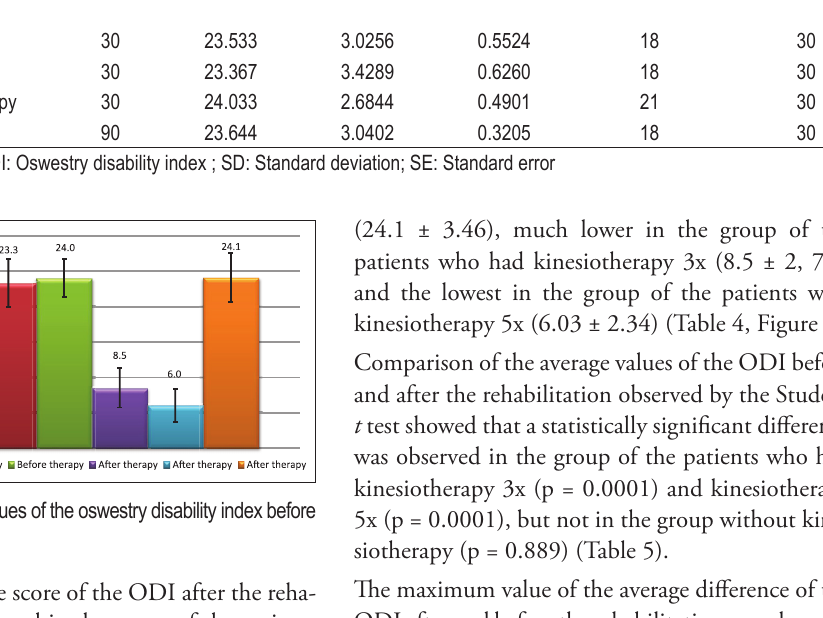
TABLE 3. Average values of oswestry disability index before treatment and comparison between the groups N X SD